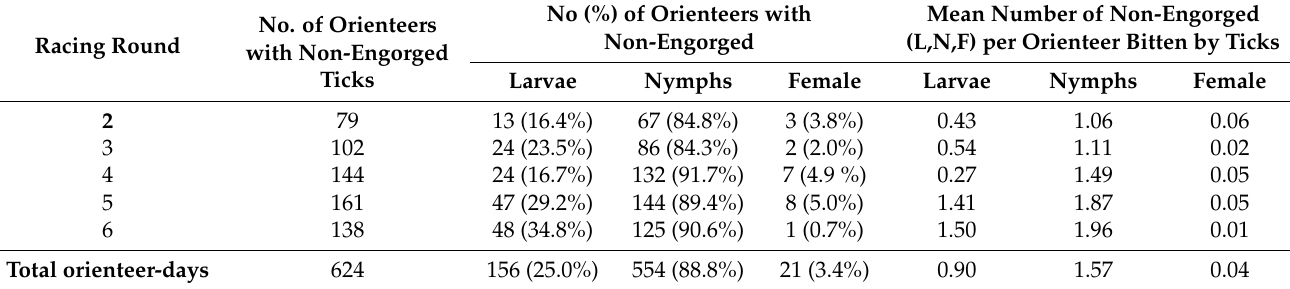
Table 3. Data summary of the infestation of orienteers by non-engorged ticks per racing round. Number and proportion of orienteers submitting non-engorged larvae, nymphs, and females per racing round and mean number of ticks per orienteer-days.